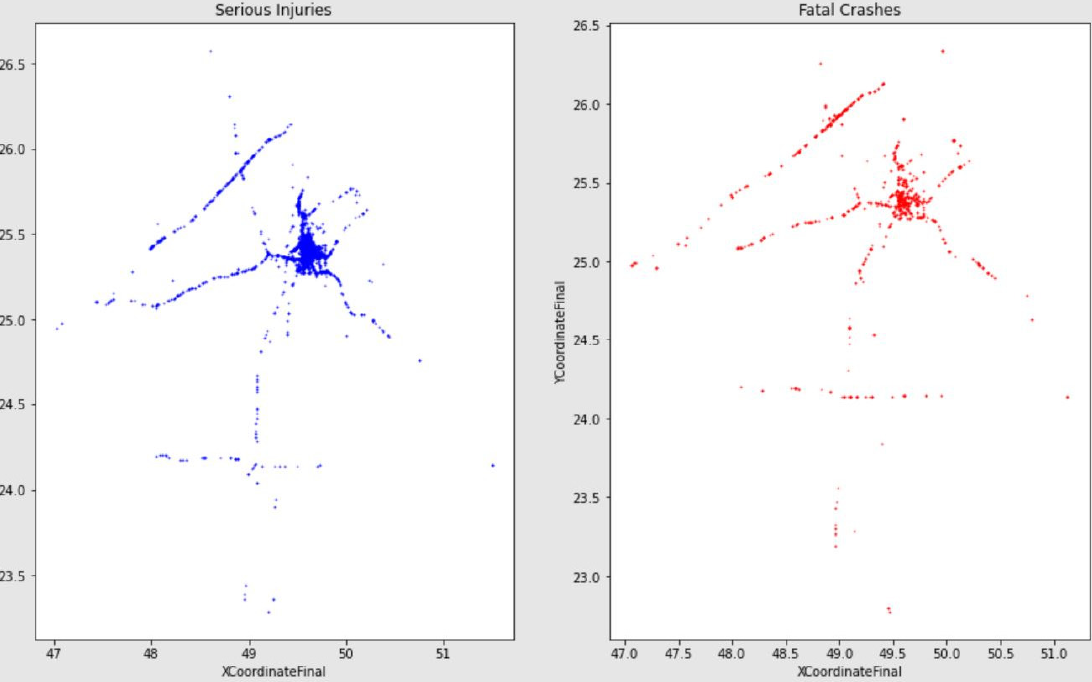
Figure 5. Map of fatal and serious injury crashes in Al-Ahsa.